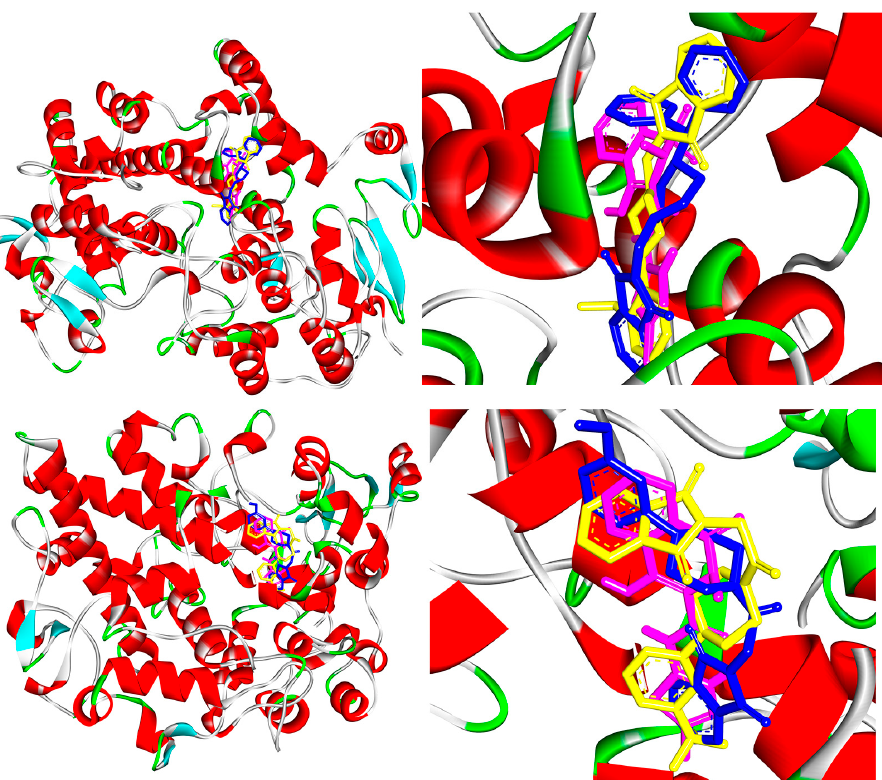
Figure 3. Docking poses of compounds B (yellow), D (blue), and meloxicam (red) inside COX-1 active site ( above ) and docking poses of F (yellow), H (blue), and Meloxicam (red) inside COX-2 active site ( bottom ).